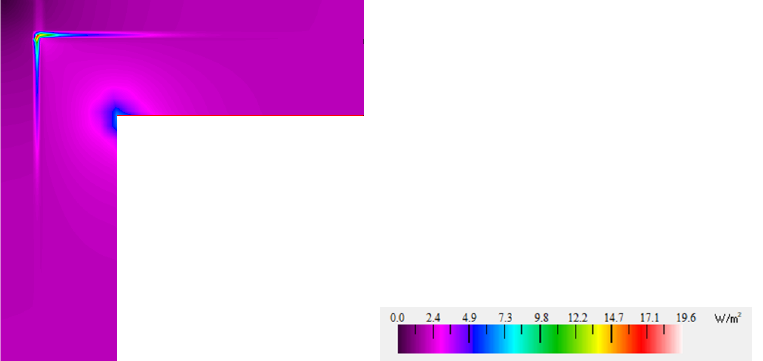
Figure 6. The heat flow rate through the wall corner insulated with aluminum foil-faced PIR, without aluminum foil at the joint between boards and with PU glue in the joint. Figure 7. The heat flow rate through the wall corner insulated with: ( a ) aluminum foil-faced PIR, without PU glue in the joint; ( b ) PIR without facing and without PU glue in the joint.